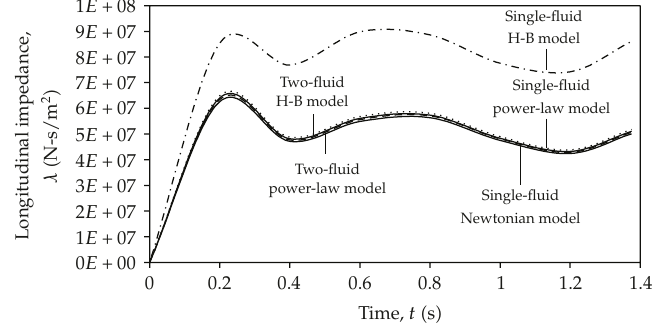
Figure 10: Variation of the longitudinal impedance to flow with time at the middle of the stenosis for di ff erent fluid models with α (cid:7) 0.95, φ (cid:7) 0.1 ◦ , τ m (cid:7) 0.1 a , μ H (cid:7) 0.035, μ N (cid:7) 0.3 μ H , and τ y (cid:7)